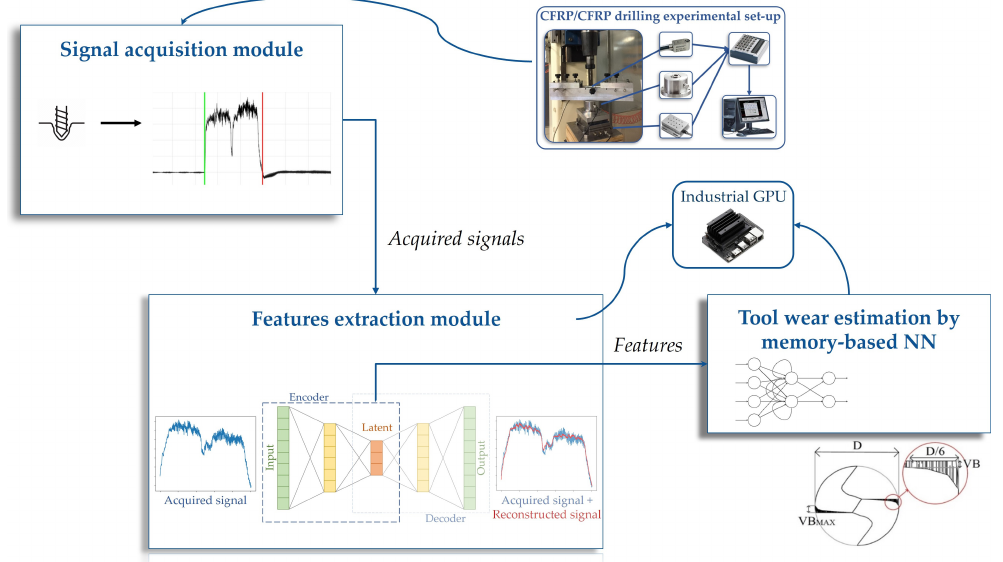
Figure 4. Scheme of smart sensor monitoring architecture developed in this work. Using the acquisition system described in the introduction and the pre-processing methodology presented in Section 2.2, signals from different sensors are acquired. The raw signals are given in input to an autoencoder neural network that extracts features from the signals. These features are given in input to a memory-based neural network that is used to estimate the tool wear at the end of the current drilled hole. The two software modules are trained, tested, and deployed on an industrial